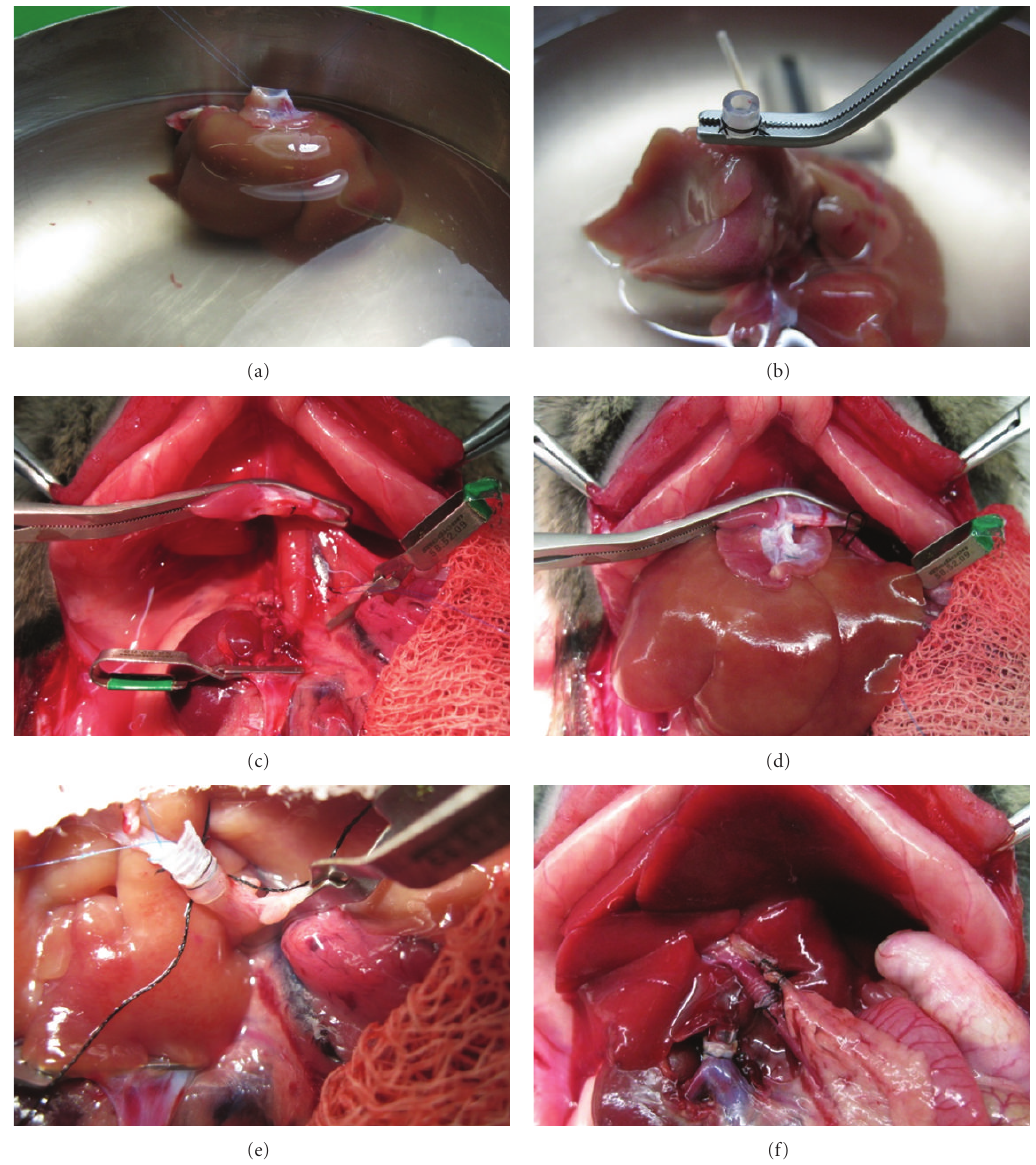
Figure 4: Liver transplantation procedure. (a) Suprahepatic cava vein prepared for the anastomosis. (b) Inferior vein cava cu ff attachment. (c) Anhepatic phase in the recipient rat. (d) Anastomosis of suprahepatic cava vein by continuous suture. (e) Portal vein anastomosis through the cu ff method. (f) Anastomosis of the bile